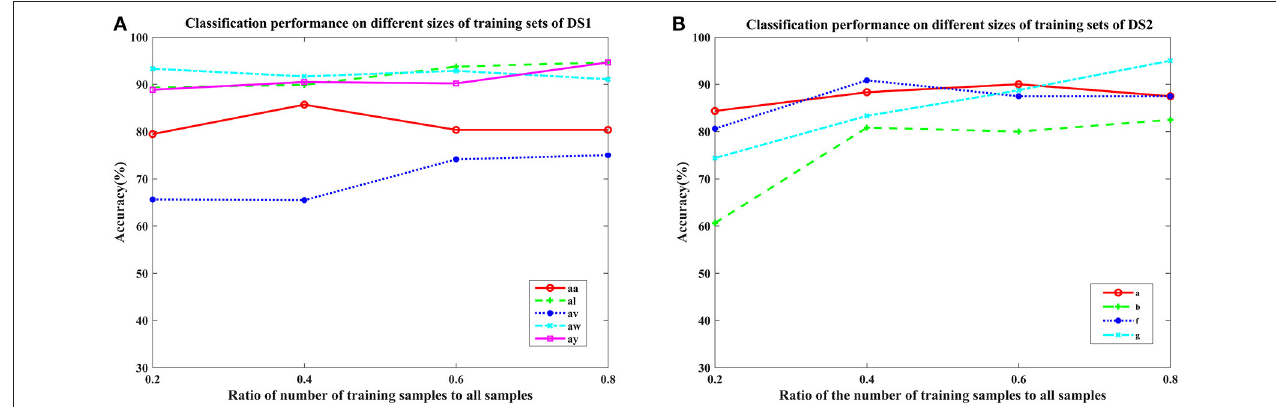
FIGURE 5 | Average classification accuracy of COL with the ratio of the number of training samples to all samples varying from 0.2 to 0.8 with step 0.2 on nine subjects: (A) aa, al, av, aw, and ay of DS1, and (B) a, b, f, and g of DS2. Each line type represents a subject’s classification accuracy at different training samples.